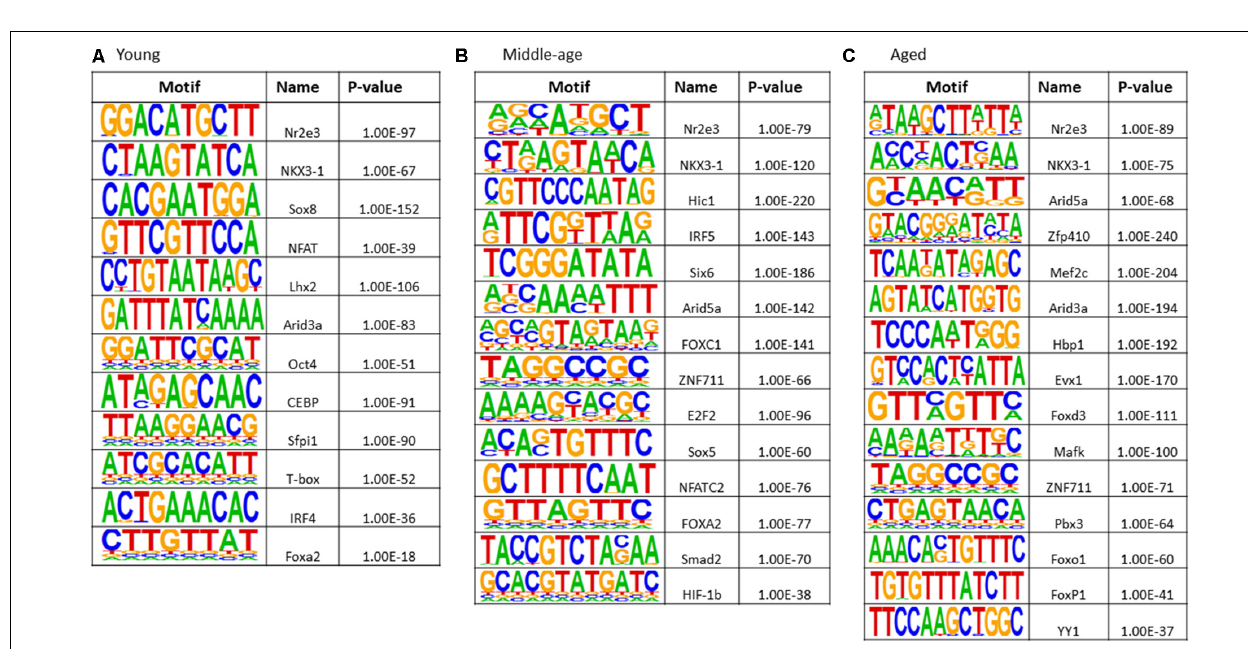
FIGURE 8 | Transcription factor binding motif enrichment analyses for E2-treatment versus control in (A) young, (B) middle-age, and (C) aged animals.